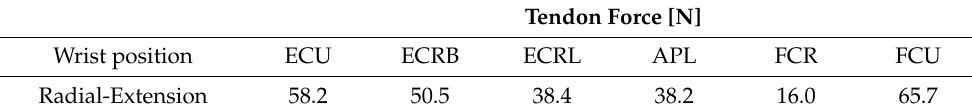
ECU = Extensor Carpi Ulnaris ECRB = Extensor Carpi Radialis Brevis ECRL = Extensor Carpi Radialis